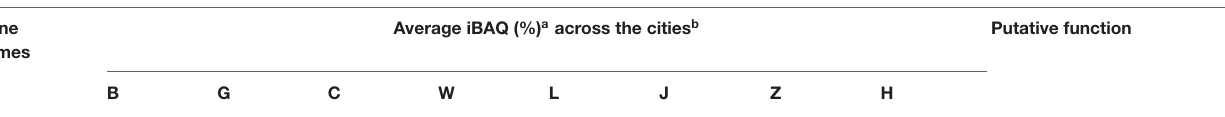
TABLE 2 | Most abundant protein identified in eight